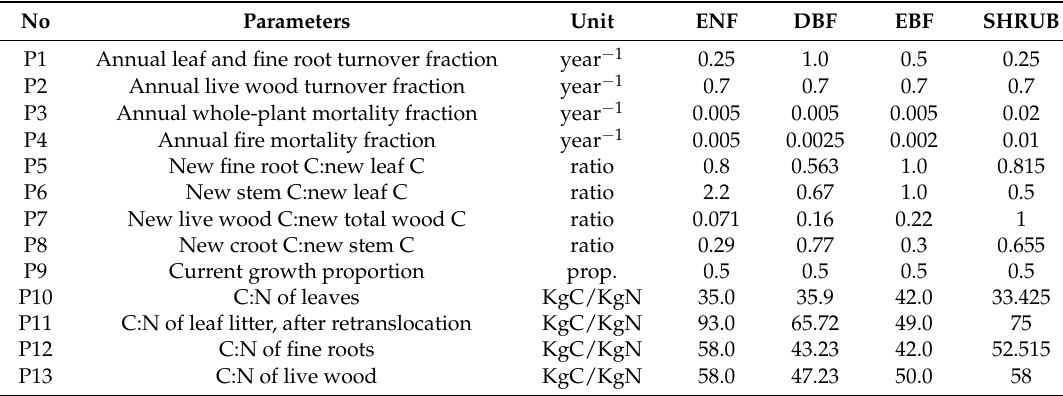
Table 2. Value of ecophysiological parameters of forests used in